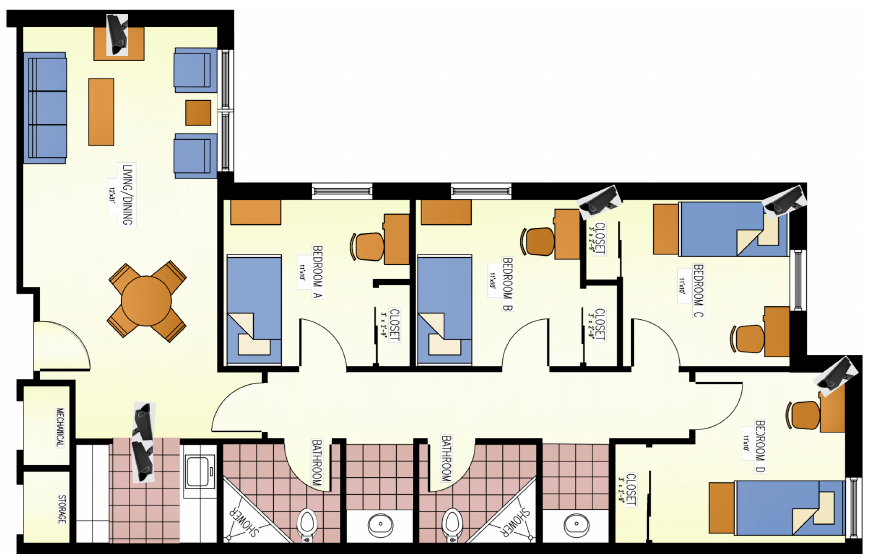
Figure 1. Floorplan of the apartment and placement of the six cameras in the apartment. Cameras were placed such that the area of the coverage is maximized.